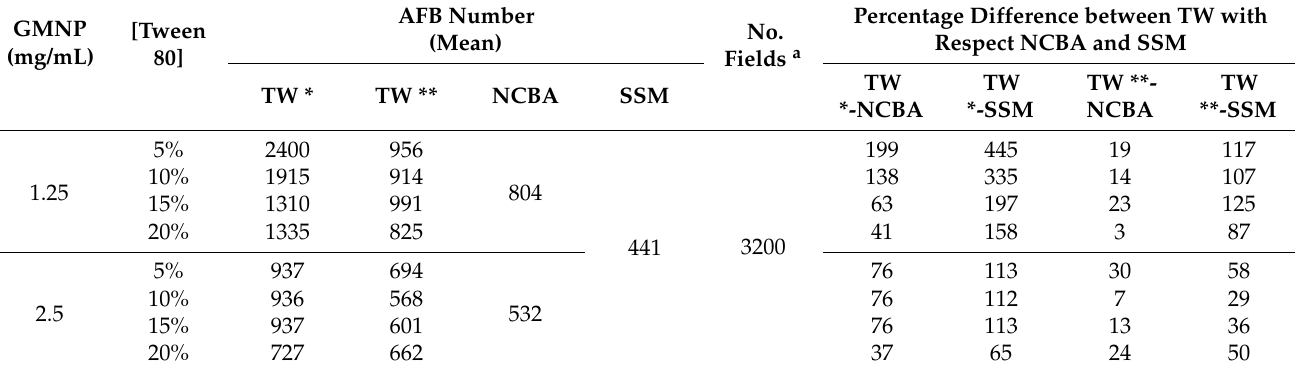
Figure 4. Comparison of AFB means in smears, evaluated at GMNP concentrations of 1.5 and 2.5 mg/mL, incubated with Tween 80 at 5–20% for 3 and 10 min. Statistical comparisons were made between data sets based on GMNP, Tween 80 concentrations, and incubation time by ANOVA. The numbers in the bars represent the mean values. The letter a indicates statistically significant differences for the rest of the categories analyzed ( p < 0.05). The error bars represent the 95% confidence intervals. n = 4 pools. Table 5. Comparison of percentage differences in the mean number of quantified bacilli in smears evaluated by SSM and NCBA with GMNP (1.25 and 2.5 mg/mL) and with Tween 80 (5, 10, 15, and 20%) as a dispersant agent for GMNP-AFB